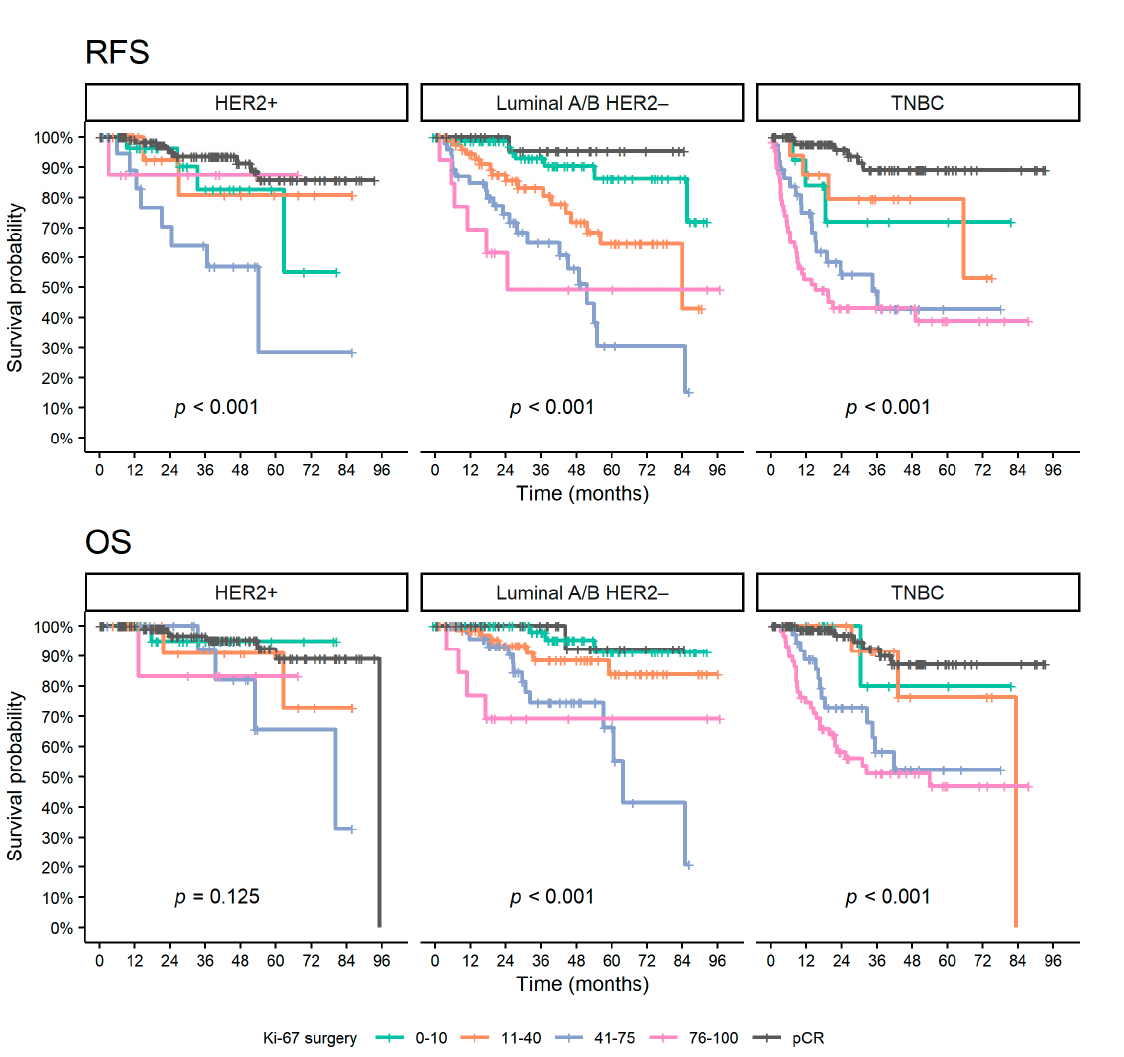
Figure 3. Histograms of Ki-67 pre- (top) and post-NAT (bottom) levels and comparison of Ki-67 levels (center). Abbreviations: TNBC, triple-negative breast cancer; HER2, human epidermal growth factor receptor 2; NAT, neoadjuvant treatment.